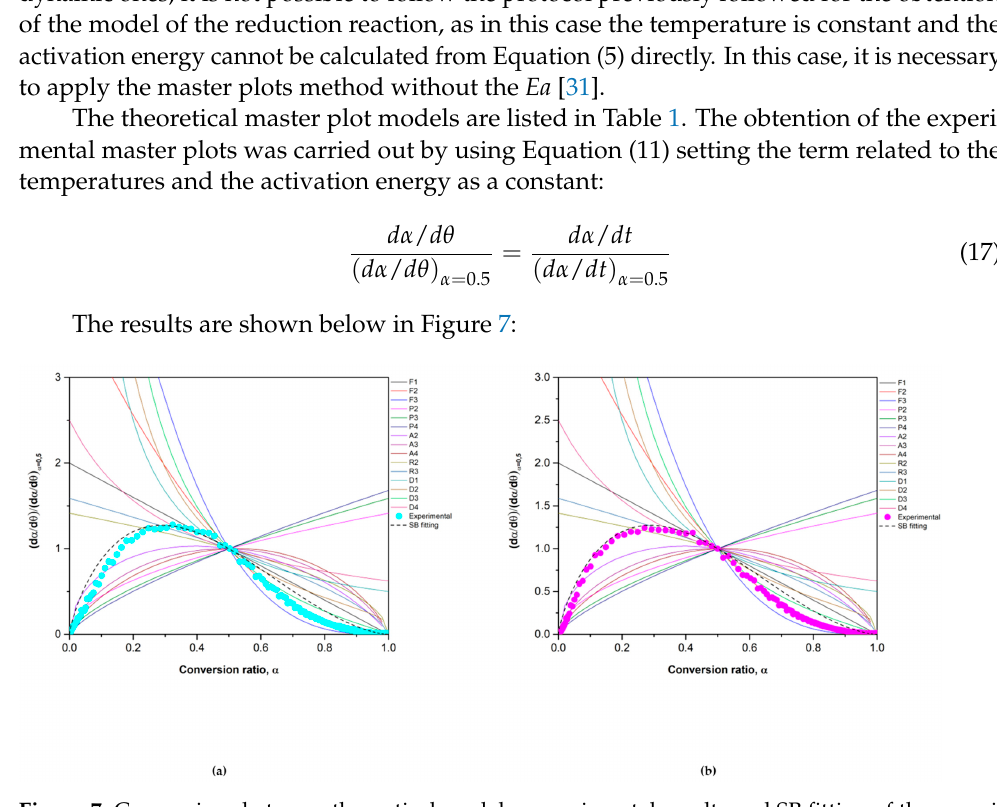
Figure 7. Comparison between theoretical models, experimental results and SB fitting of the experimental results for ( a ) Co 2.4 Ni 0.6 O 4 and ( b ) 0.5% SiO 2 /Co 2.4 Ni 0.6 O 4 .